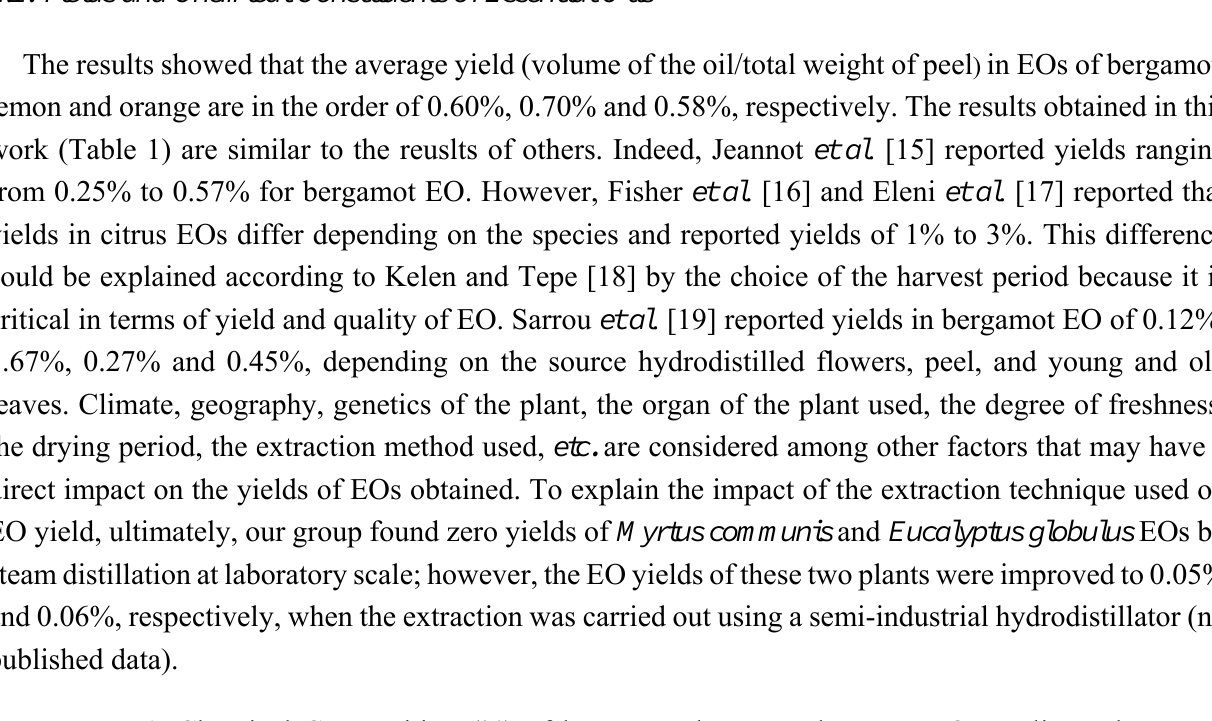
Table 1 . Chemical Composition (%) of bergamot, lemon and orange EOs acclimated to Algeria from fresh peel parts as identified by GC-MS